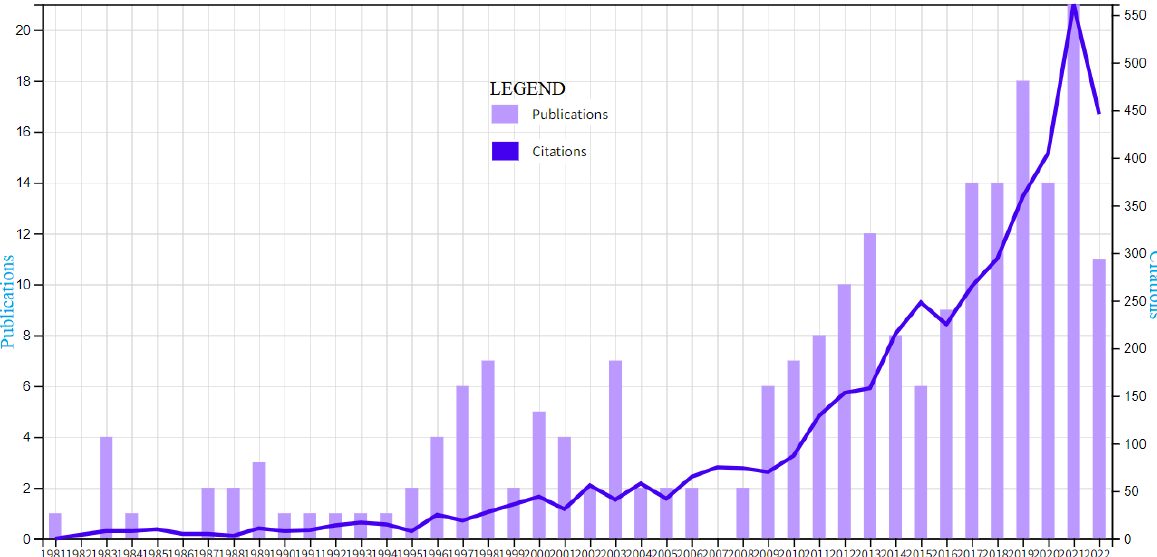
Figure 9. The number of citations and number of publications from 1981 to 2022 for the research on “marine hose” research (data retrieved from WoS database, 24 July 2022).